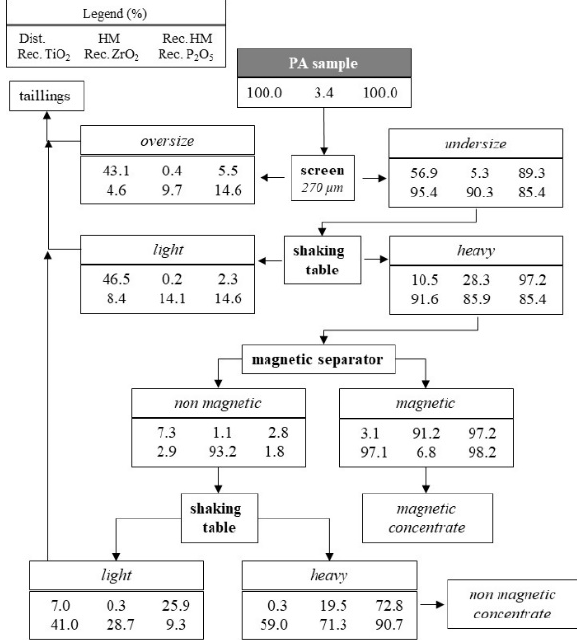
Figure 10. Particle size distribution of the PA sample ( a ) and mass and metallurgical balances ( b